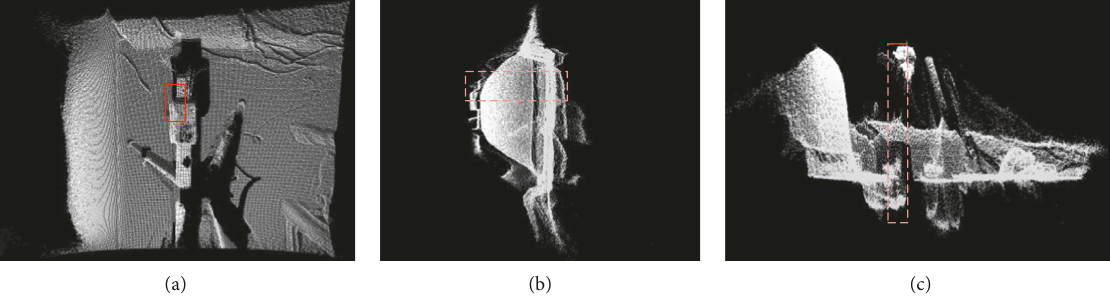
Figure 9: ROI (highlighted in red) for vibration measurement in the cantilever steel beam experimental case 1. 3D point cloud: (a) front view, (b) left view, and (c) top view.